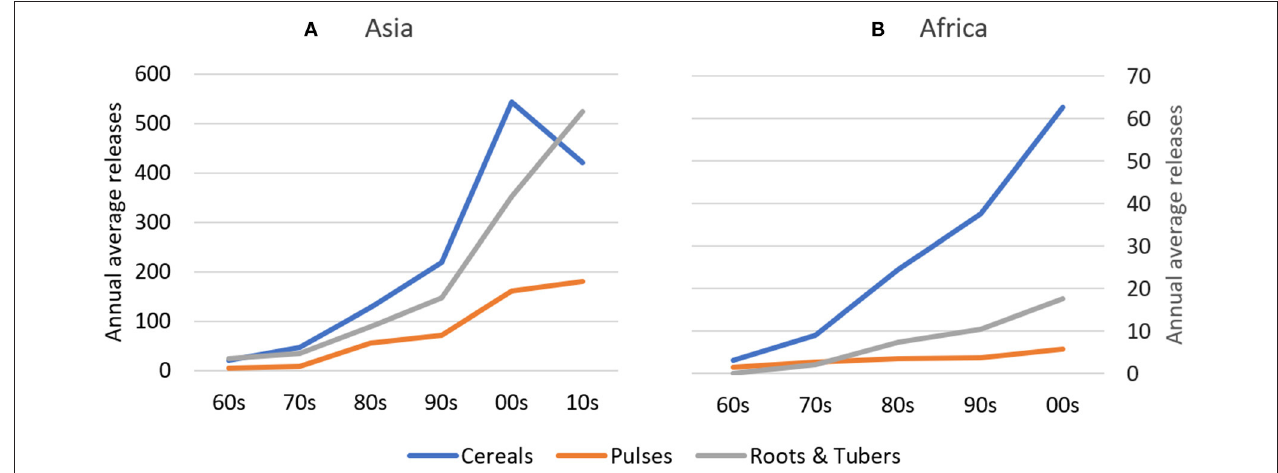
FIGURE 2 | Annual Average Releases of Cereal, Pulse, and Root & Tuber Crop Varieties in Asia and Africa between the 1960s and 2010s. In (A) , cereal values refer to the left axis; pulses and roots & tubers values refer to the right axis of (B) . Given the slightly unbalanced dataset, inter-crop comparison should be made with caution.